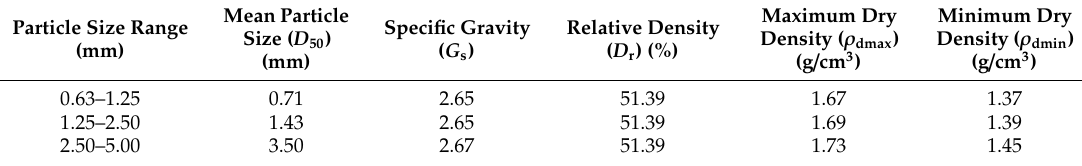
Figure 3. Soil samples with three ranges of particle size: ( a ) 0.63–1.25 mm sand; ( b ) 1.25–2.50 mm sand; ( c ) 2.50–5.00 mm sand. Table 1. Basic physical properties of sand samples with different particle size ranges.